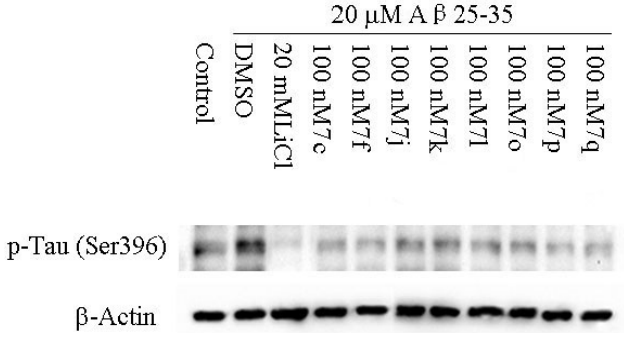
Figure 2. Effects of GSK-3 β inhibitors on Tau phosphorylation (ser396) in SH-SY5Y